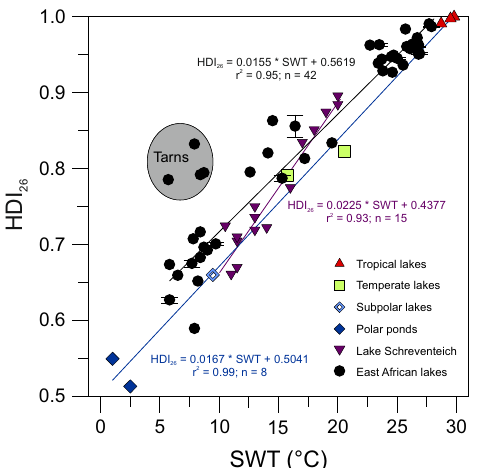
Fig. 5 Cross plot of HDI 26 (heterocyte diol index of 26 carbon atoms) values versus surface water temperature (SWT) in East African and other globally distributed lakes and ponds. Note that the four high- elevation tarns of Biozone 3 (>4300 masl) are not included in the calculation of the correlation coef fi ciency of East African lakes (black regression line and calibration). For comparison, regression lines of SWT and HDI 26 values extracted from surface sediments of tropical to polar lakes and ponds (blue regression line and calibration) as well as water column samples (purple regression line and calibration) of temperate Lake Schreventeich 16 are displayed, showing regional differences in the correlation between the synthesis of heterocyte glycolipids and water temperatures. Black dots = African lakes; red triangles = tropical Indonesian lakes; green squares = temperate European lakes; open blue diamond = subpolar Laguna Potrok Aike; dark blue diamonds = Antarctic meltwater ponds; purple triangles = water column samples of Lake Schreventeich 16 . Error bars indicate the SD based on replicate sample